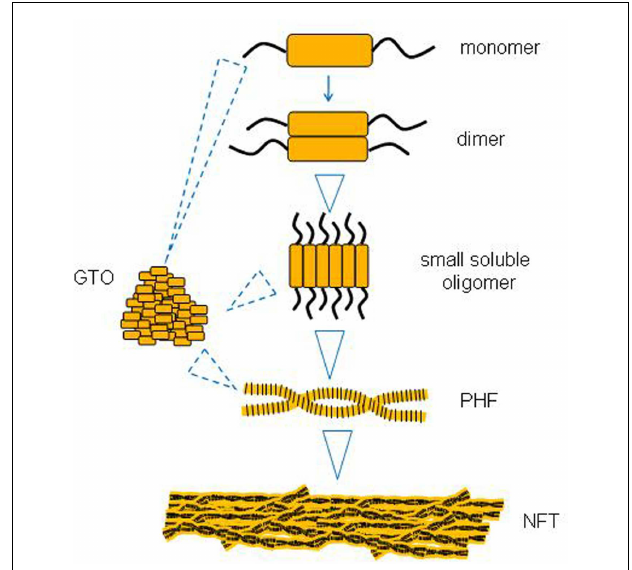
FIGURE 1 |A putative sequence of events in tau aggregation into neurofibrillary tangles (NFTs)